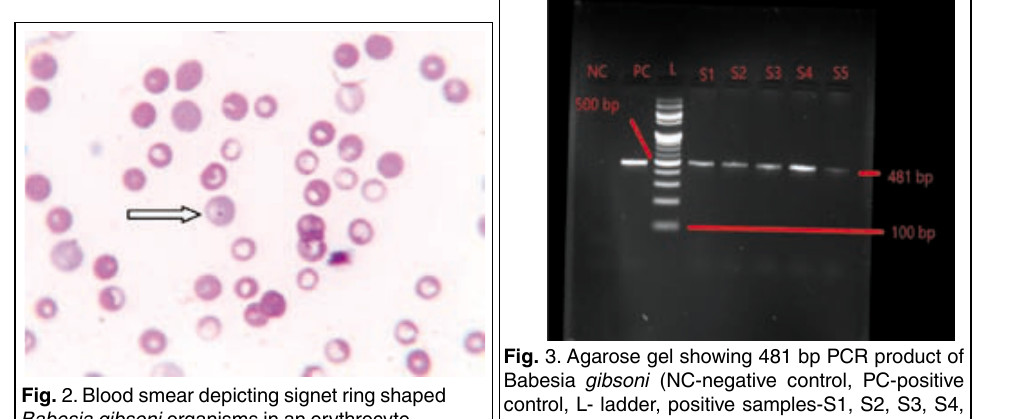
Fig. 2. Blood smear depicting signet ring shaped Babesia gibsoni organisms in an erythrocyte